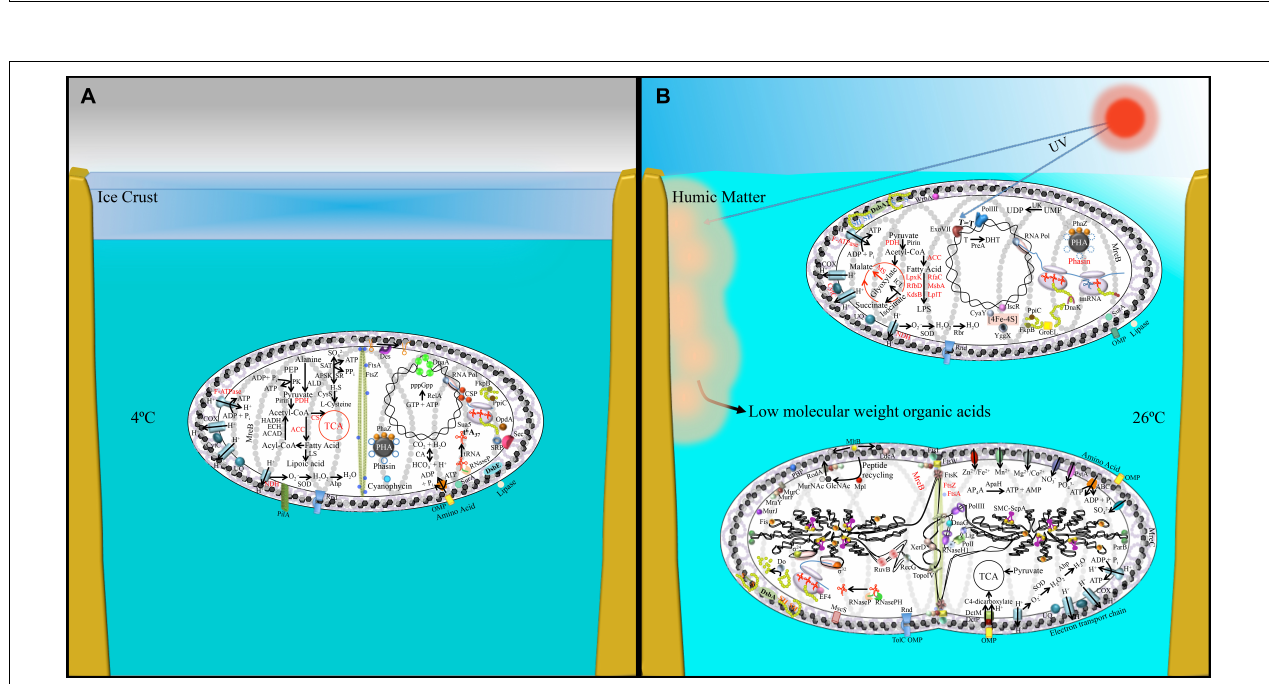
FIGURE 4 | Circos plots showing the direct link between methylome (IPD ratio), transcriptome, and proteome data recorded in the Polynucleobacter asymbioticus strain QLW-P1DMWA-1 T . The remaining data have been omitted to highlight only one-to-one relationships across the three levels. Genes painted in the plots are enlisted in Supplementary Table S8 . Outermost ring: the 2.15-Mb genome of this strain. Second internal ring: methylation pattern recorded at (A) 4 ◦ C and (B) 26 ◦ C*-incubation. Third ring: methylation recorded at 26 ◦ C-incubation. Here, methylations only within the open reading frame and 500-bp upstream of the genes are shown. Fourth ring: the transcribed genes in (A) 4 ◦ C and (B) 26 ◦ C*-incubation. Fifth internal ring: protein expression profile in (A) 4 ◦ C and (B) 26 ◦ C*-incubation. Color gradient bar: red = higher expression, blue = lower expression at transcriptome and proteome levels.